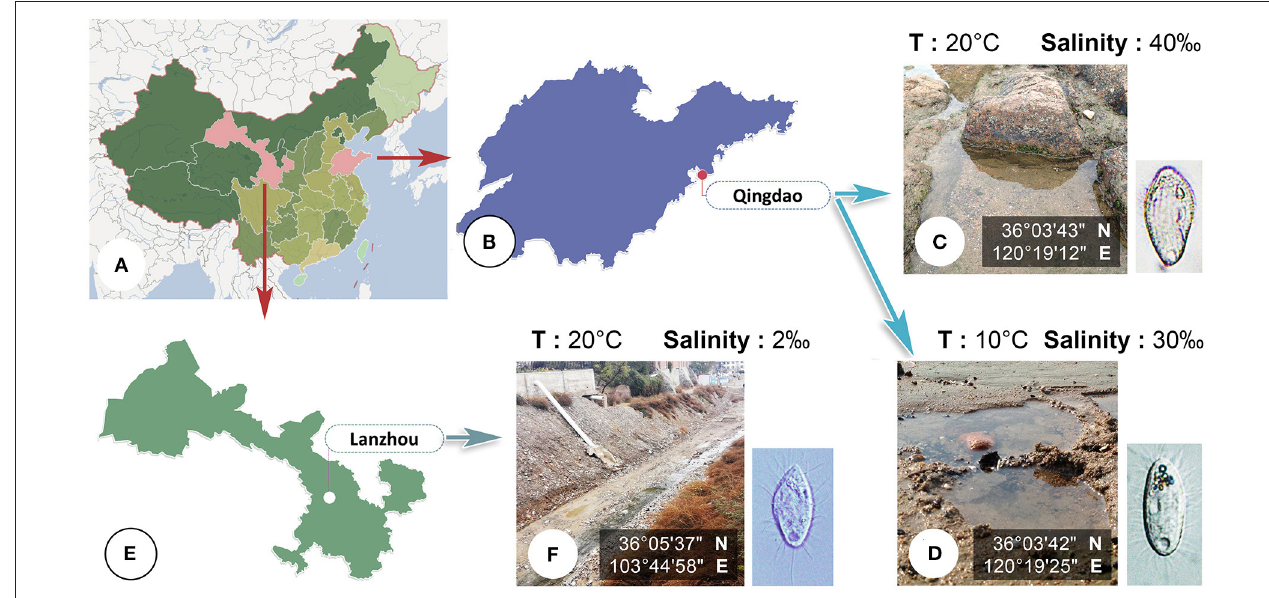
FIGURE 1 | (A–F) Map, sampling sites and habitats. (A) Map of China. (B) Shandong Province, showing the location of Qingdao. (C,D) Photographs of sampling sites in Qingdao where Citrithrix smalli sp. nov. (C) and Uronema orientalis Pan et al., 2015 (D) were collected. (E) Gansu Province, showing the location of Lanzhou. (F) Photograph of sampling site in Lanzhou where Homalogastra binucleata sp. nov. was